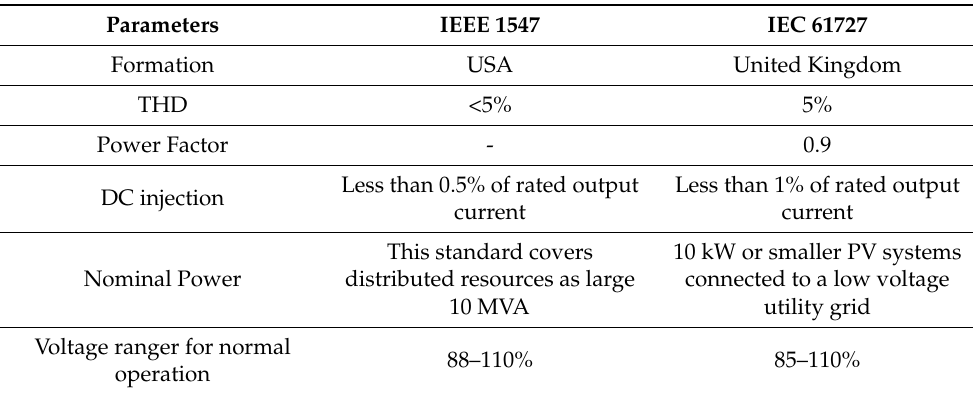
Table 1. Standards of PV-interconnected